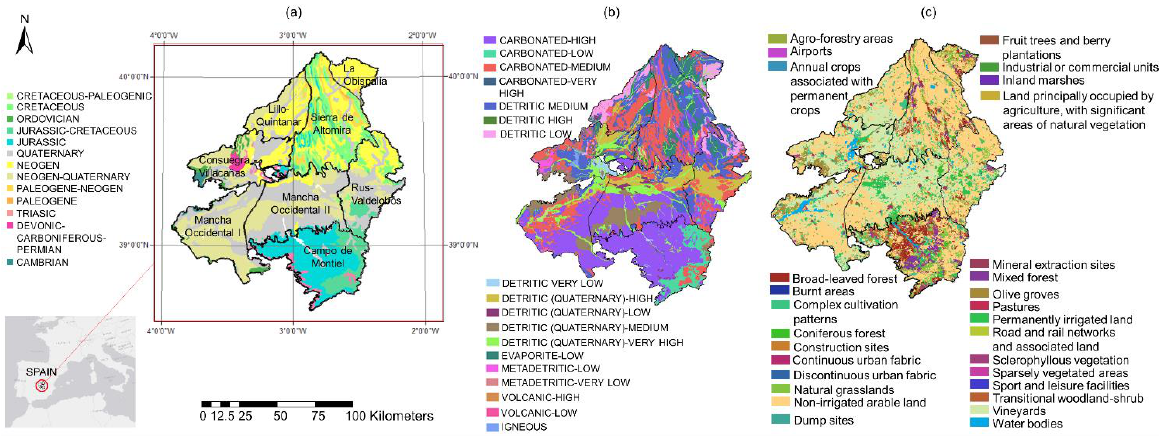
Figure 2. Case study: ( a ) geological map; ( b ) hydrogeological characteristics and permeability; ( c ) land use map.